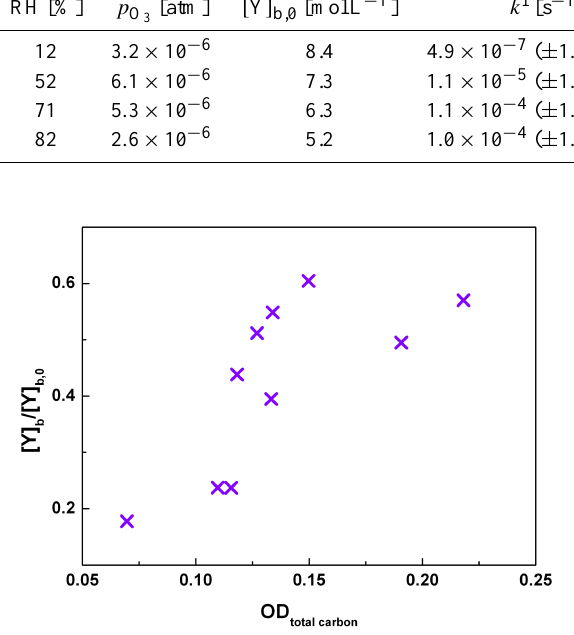
Figure 5. Size dependence of the oxidation rate: the amount of ma- terial already oxidized differs for particles of different thickness, all oxidized at 71% RH with an ozone dose of 5 . 0 × 10 − 2